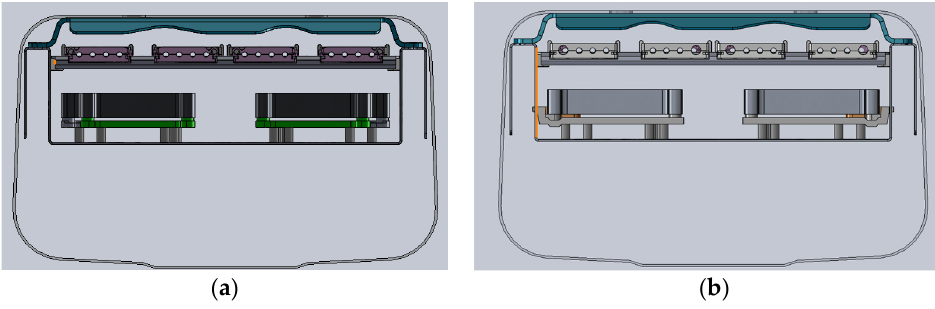
Figure 9. The deformation at the first-order natural frequency.